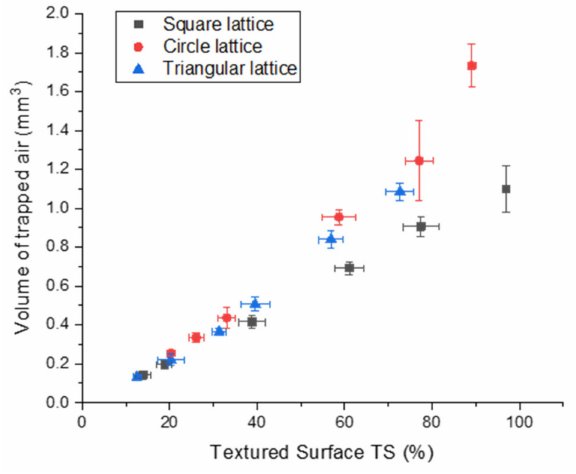
Figure 5. Volume of air trapped in a portion of 1 mm × 1 mm textured area as a function of the percentage of the textured surface (TS) for the three different texture